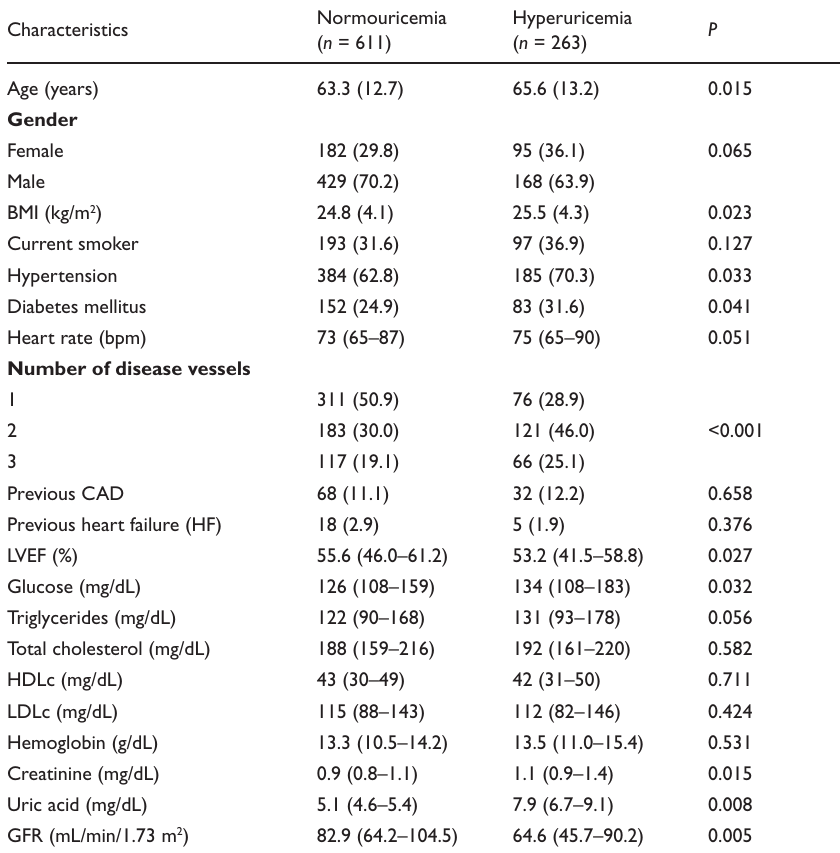
Table 1. Baseline characteristics of the participants according to the presence of hyperuricemia